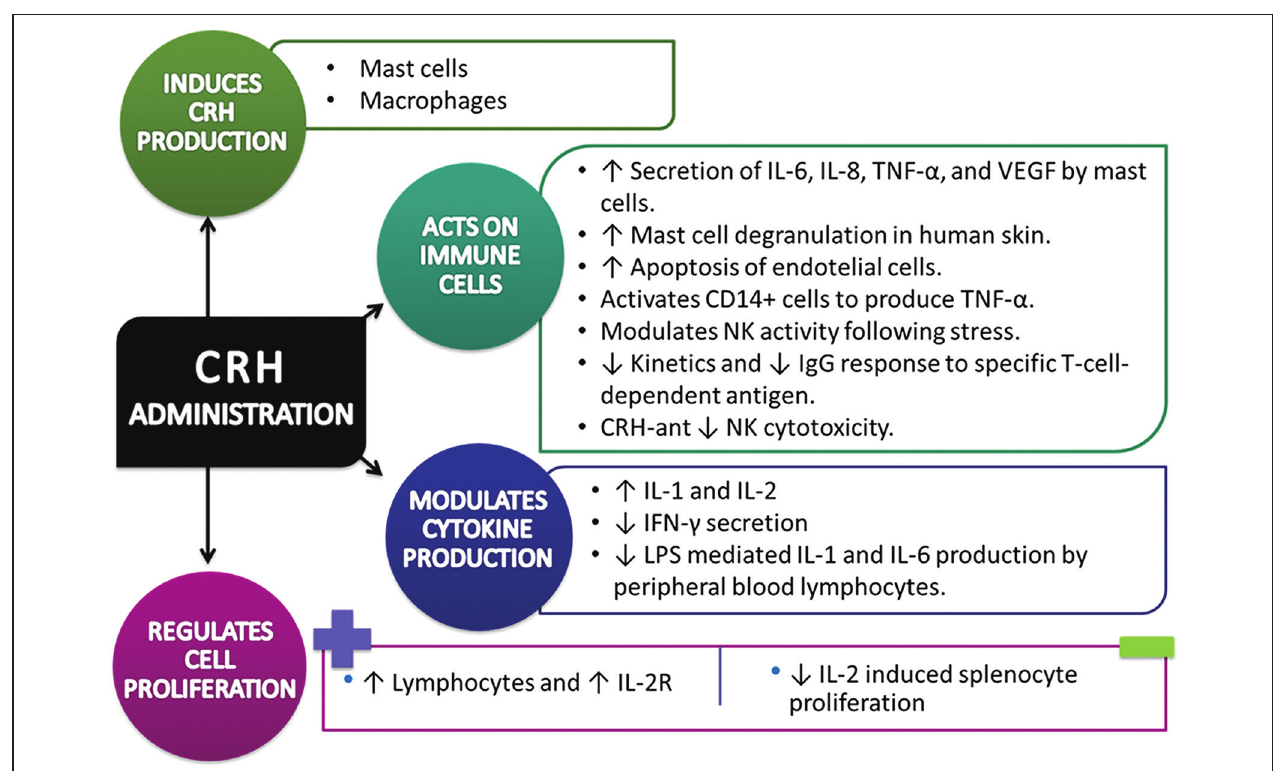
FIGURE 2 | Experimental data of Corticotropin-ReleasingHormone/Corticotropin-ReleasingHormone agonist impact on immune system cells and processes ( ↑ = increase, ↓ = decrease).